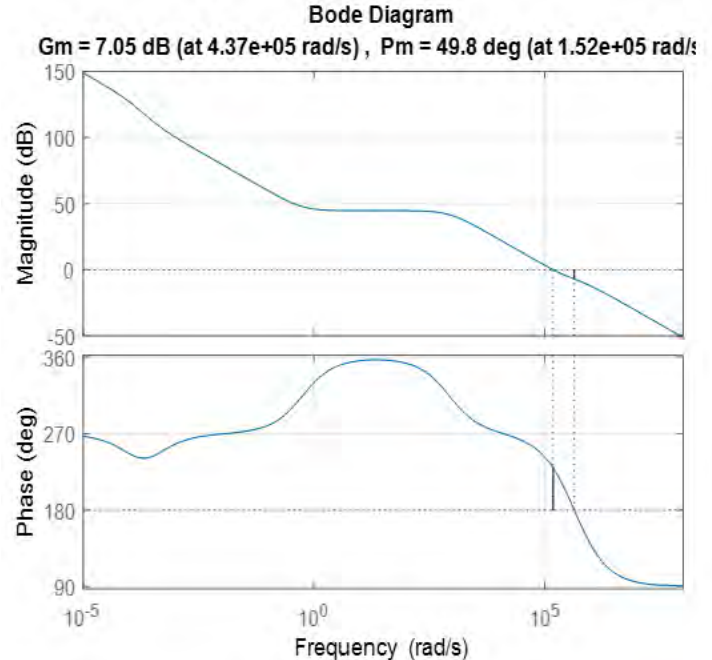
Figure 11. Bode plot of the open loop controlled output current transfer